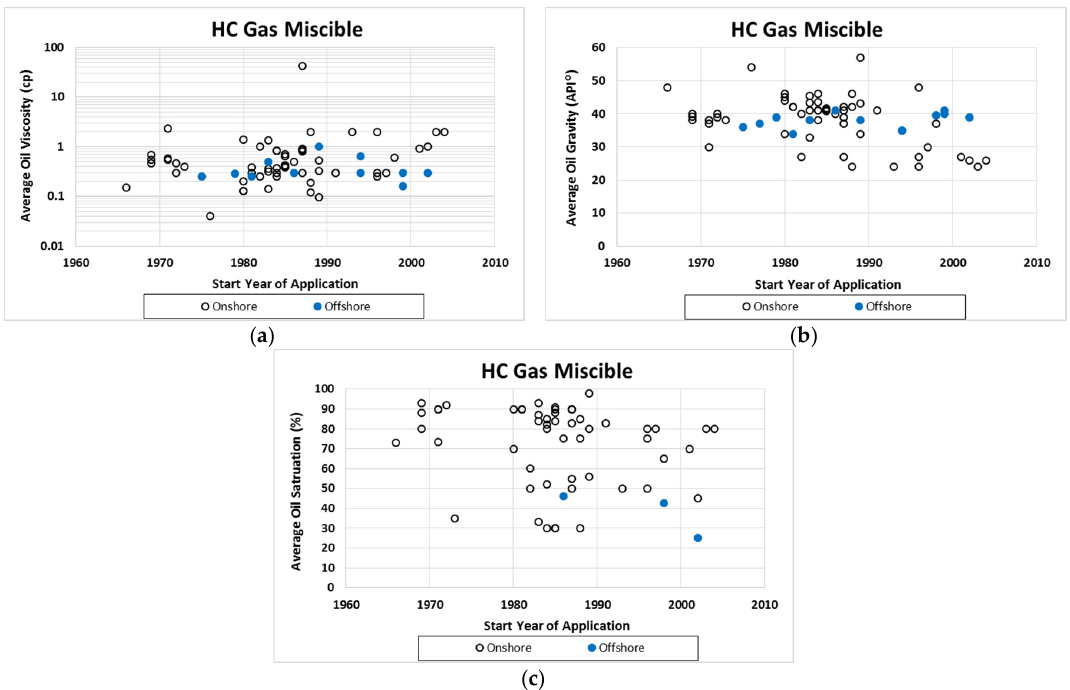
Figure 4. Application data for HC gas miscible processes by start year of application. ( a ) Oil viscosity; ( b ) Oil gravity; ( c ) Oil saturation.